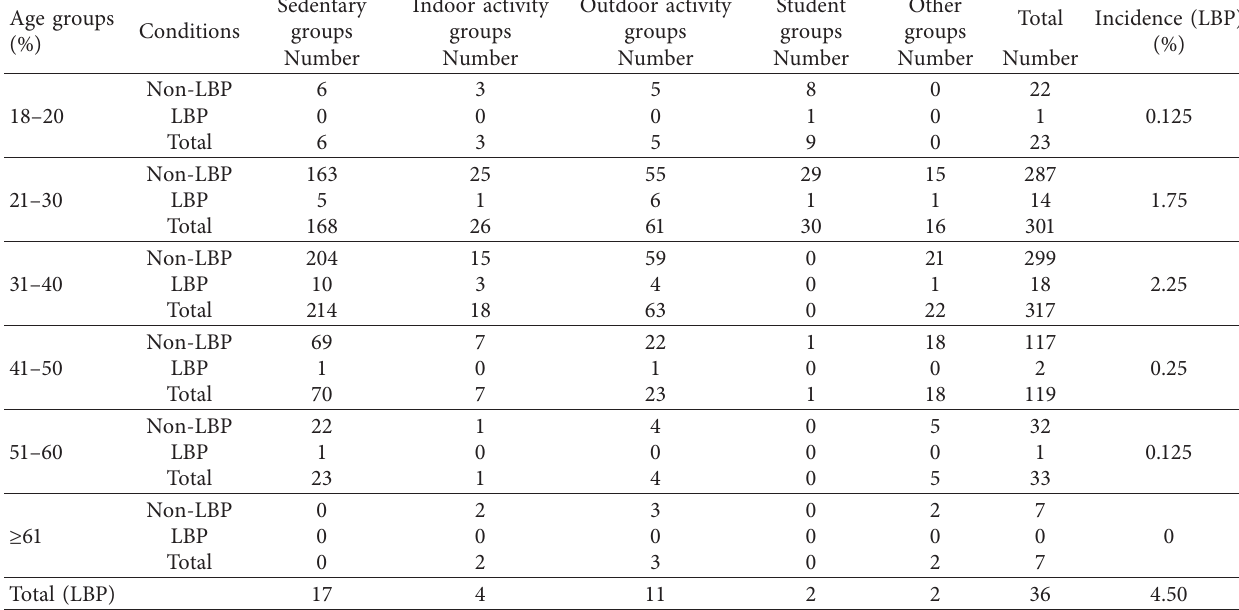
Table 1: Occupational physical activity characteristics of different age groups for